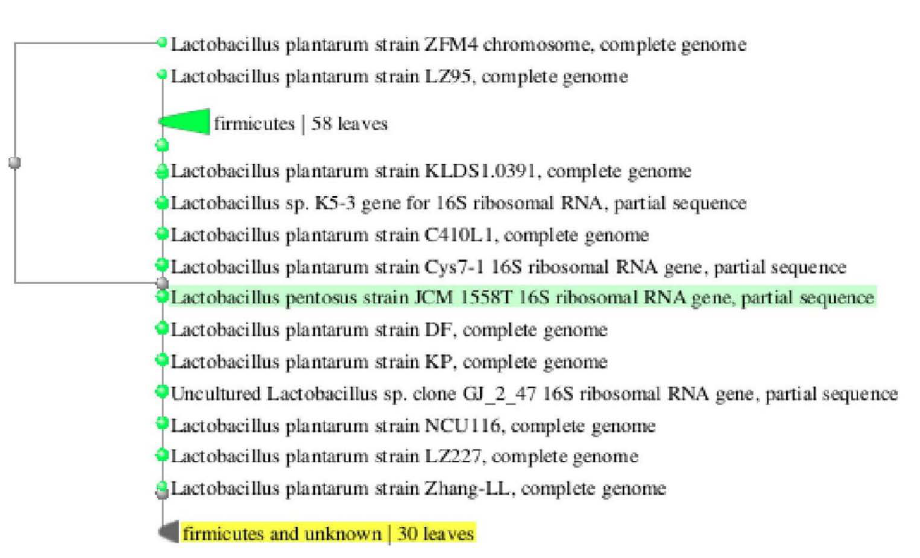
Fig. 4. (B) Phylogenetic dendogram of strain SK3 and related lactic acid bacterial species based on 16S r RNA gene sequence similarity